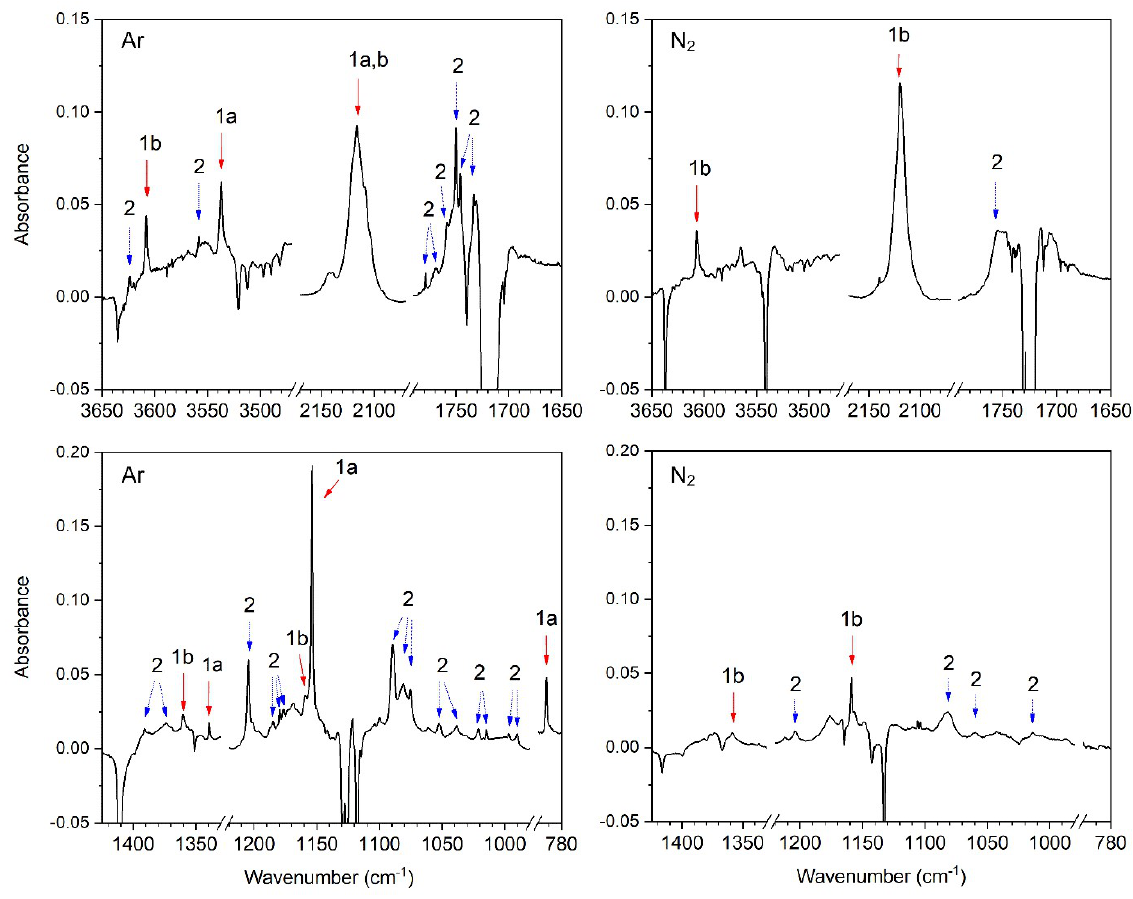
Figure 2. Selected regions of the difference spectrum of the CHOCHO/NH 2 OH/Ar(N 2 ) matrix after 90 min of irradiation minus freshly deposited CHOCHO/NH 2 OH/Ar(N 2 ) matrix at 11 K. Table 1. Comparison of the observed and calculated anharmonic wavenumbers (cm −1 ) for H(OH)CCO–NH 2